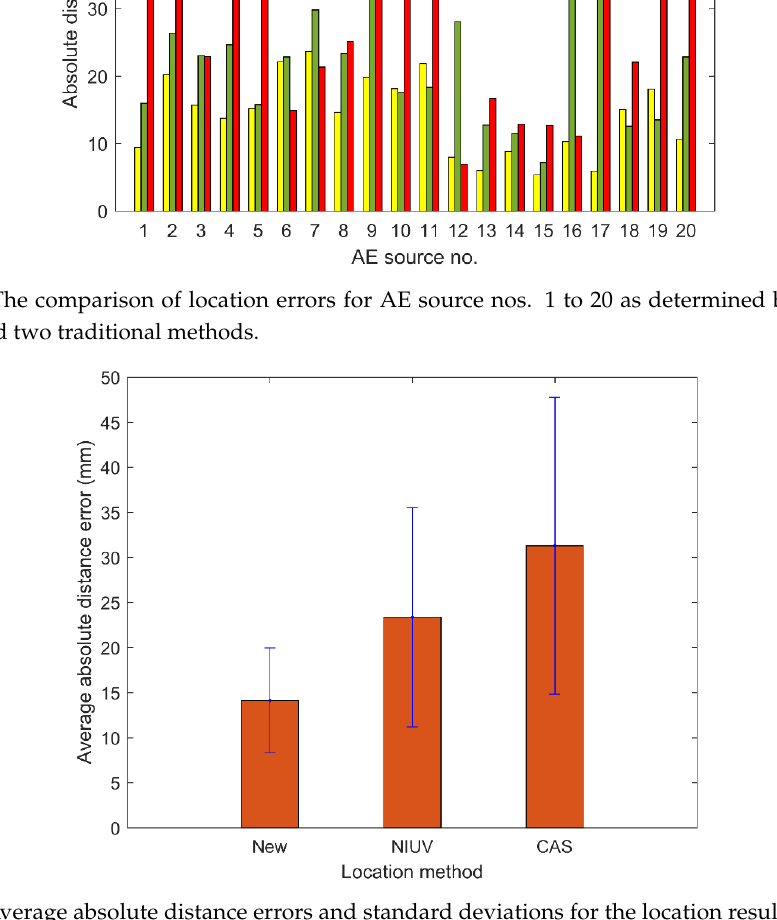
Figure 7. Average absolute distance errors and standard deviations for the location results of 20 AE sources determined by three methods.